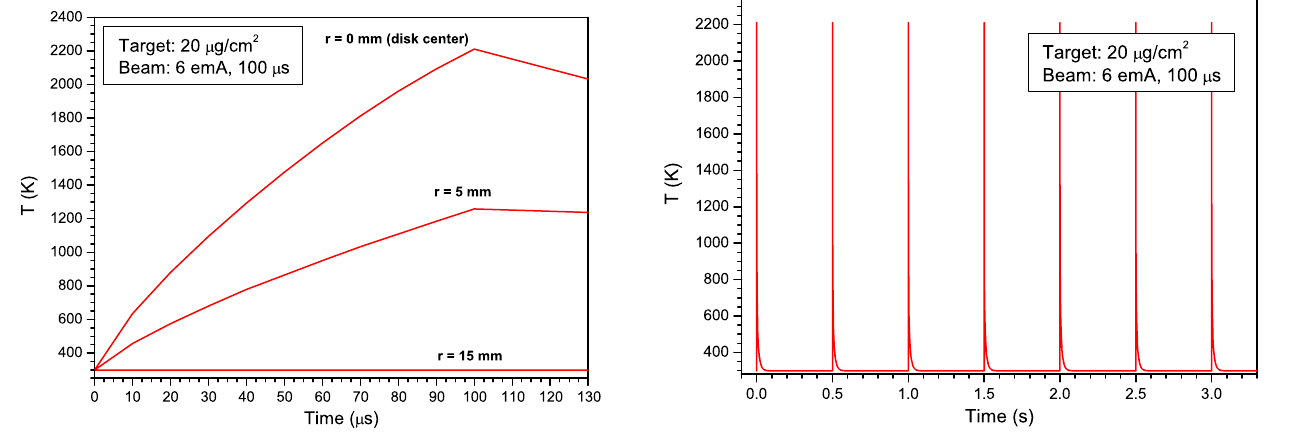
FIG. 3. Temperature vs time (during pulse length) at three different points along foil radius, foil thickness ¼ 20 μ g = cm 2 , beam current 6 emA, and pulse length ¼ 100 μ s.